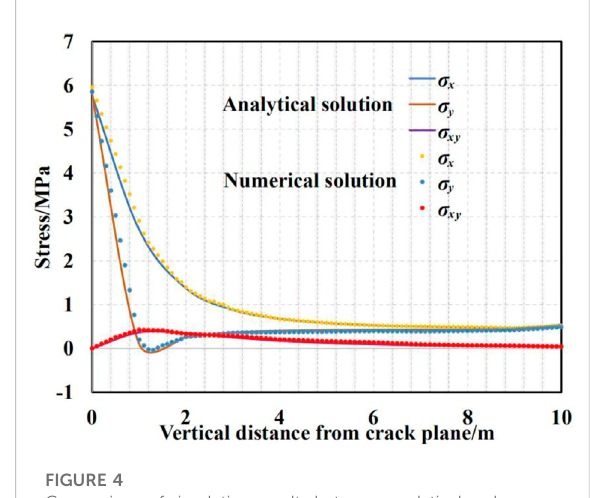
FIGURE 4 Comparison of simulation results between analytical and numerical